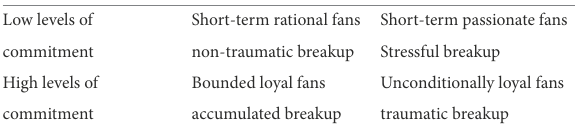
TABLE 3 Classification of fans and breakup style. Rational-oriented